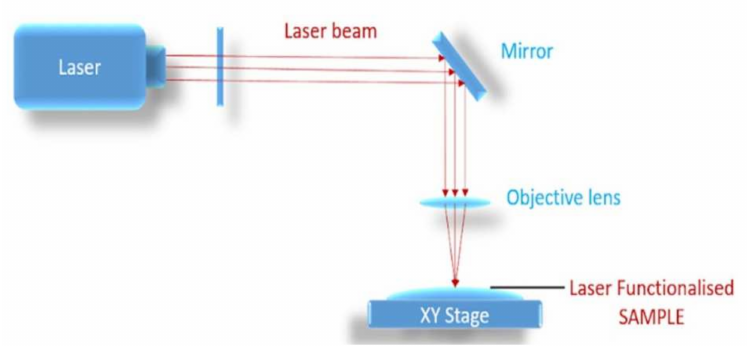
Figure 4. LDW schematic principle (Reproduced after [44]).